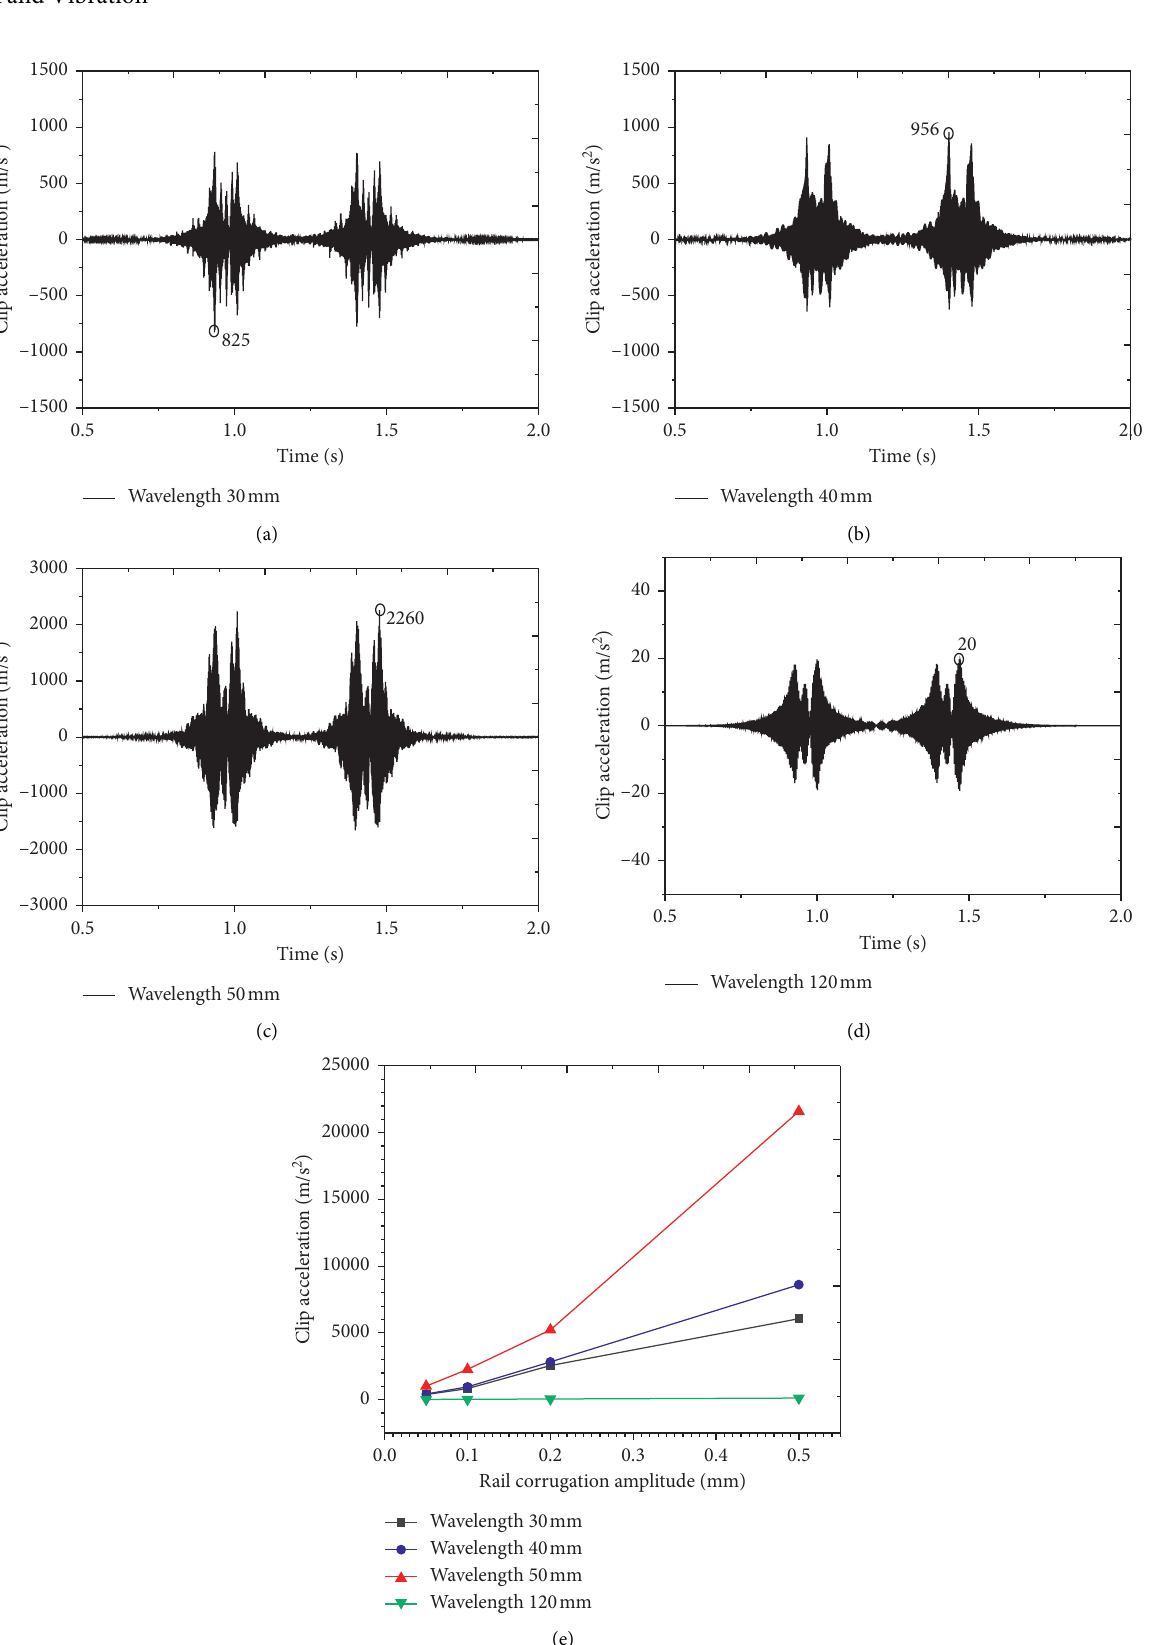
Figure 5: Vibration acceleration of elastic rail clips at different wavelengths: (a) wavelength 30mm wave depth 0.1 mm; (b) wavelength 40mm wave depth 0.1 mm; (c) wavelength 50mm wave depth 0.1mm; (d) wavelength 120mm wave depth 0.1mm; (e)